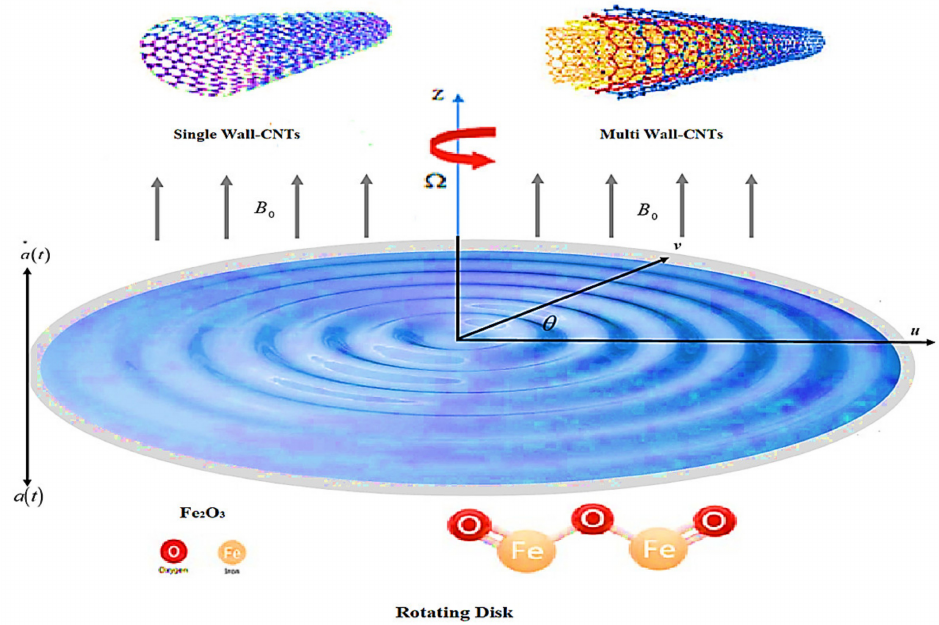
Figure 1. The physical insights of fluid flow over a rotating disk. The disk was initially kept at a ( 0 ) = h . But then with the velocity ω = a ( t ) the disk moved to vertical distance Z = a ( t ) . The buoyancy influence was assumed to be negligible. The disk spun with angular velocity Ω ( t ) at z − axis. It has been supposed that the CNTs and iron oxide nano particulates are scattered uniformly. The magnetic force of